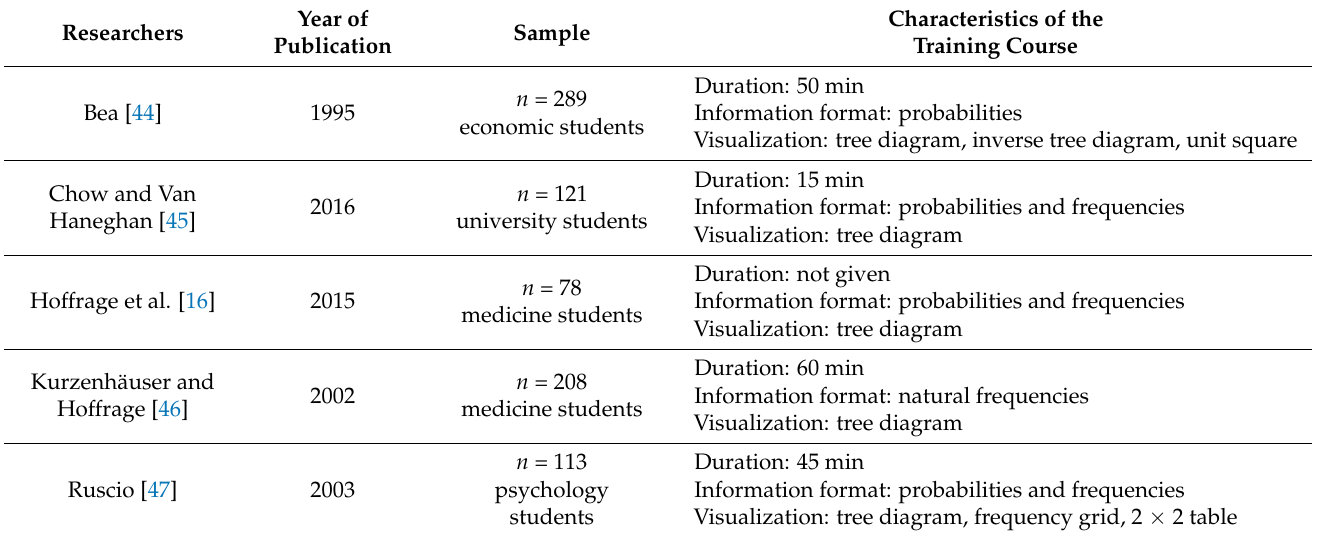
Table 1. Overview of training initiatives [16,20,44–52] for Bayesian